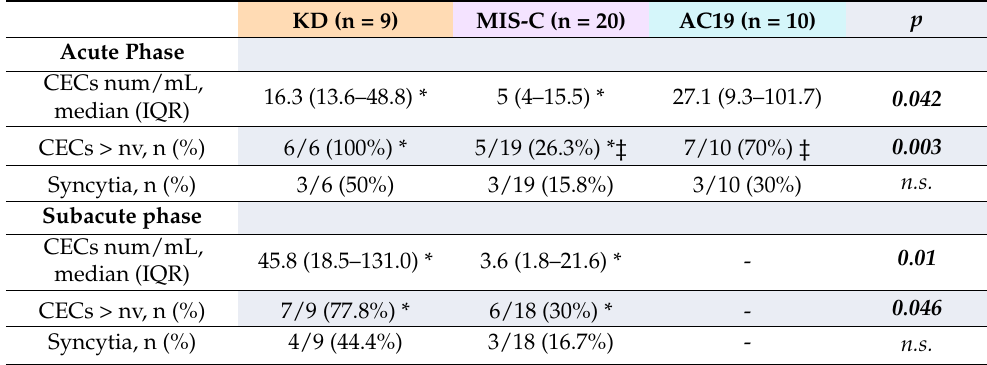
Table 4. CEC values during acute and subacute stages, in the three groups of patients.